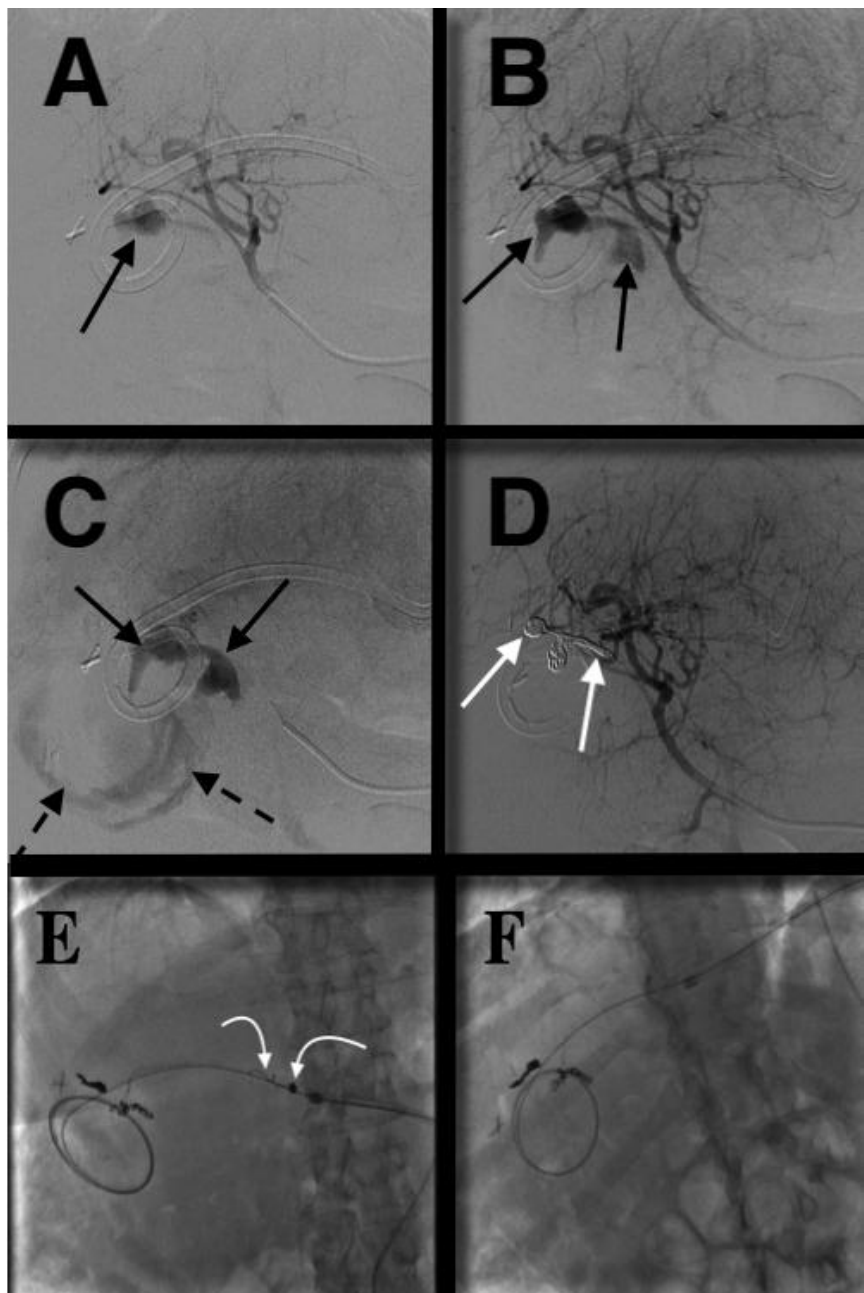
Figure 2. 71-year-old female with PTBD erosion into hepatic artery and subsequent massive upper gastrointestinal bleed. Patient had a PTBD in place for 7 years following a common bile duct (CBD) injury sustained during cholecystectomy with subsequent hepaticojejunostomy and anastomotic narrowing. This stricture failed benign biliary stricture protocol dilation. She presented to the emergency department with hematemesis, hematochezia and hypotension. ( A – C ) Initial angiogram showed extravasation from the hepatic artery (black arrows) and into the small bowel (dashed black arrows). ( D ) After coils (white arrows) were placed distally and proximally, repeat hepatic artery angiogram showed cessation of extravasation. ( E ) During a routine biliary tube exchange 7 months later, some of the coils (curved white arrows) were noted to have migrated into the bile duct and along the biliary drainage catheter. ( F ) These coils were percutaneously removed using a